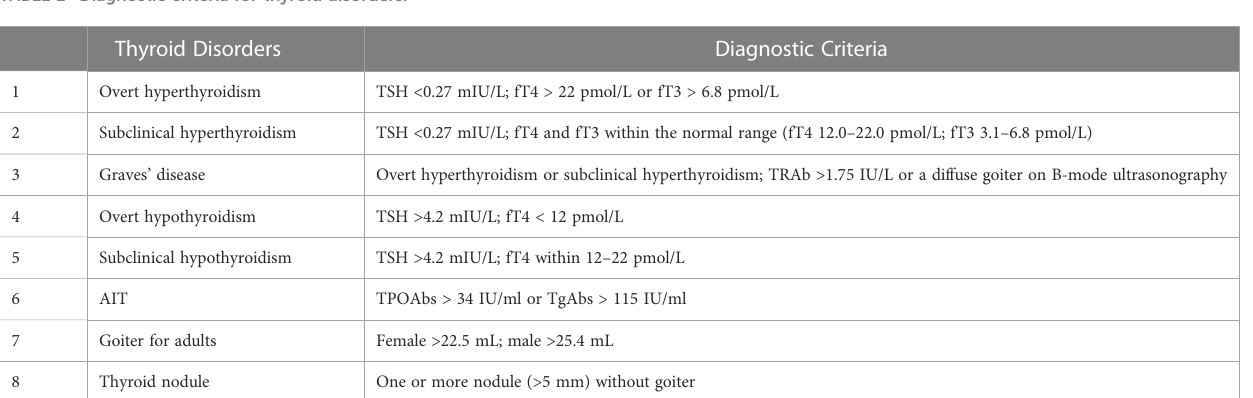
TABLE 1 Diagnostic criteria for thyroid